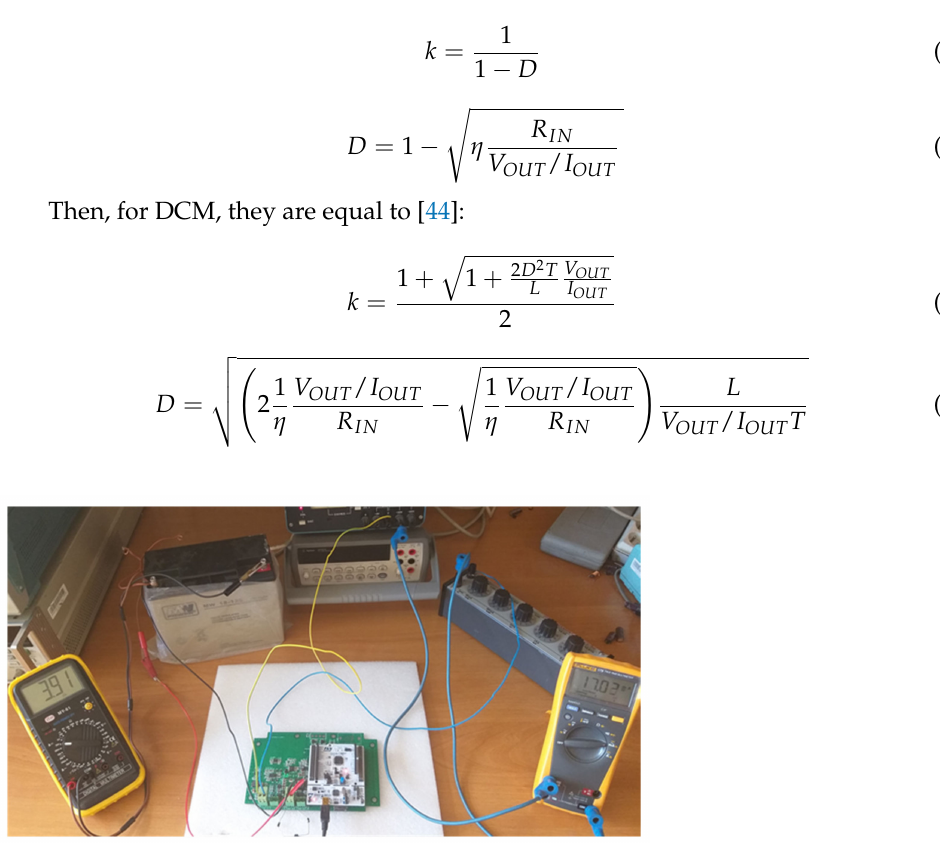
Figure 14. The prototype of EH